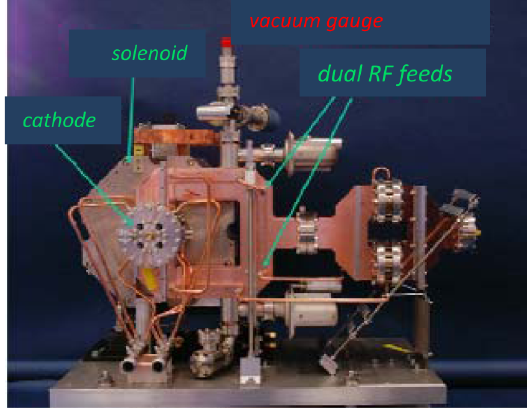
FIG. 1. Picture of the LCLS rf gun and its accessories [7].